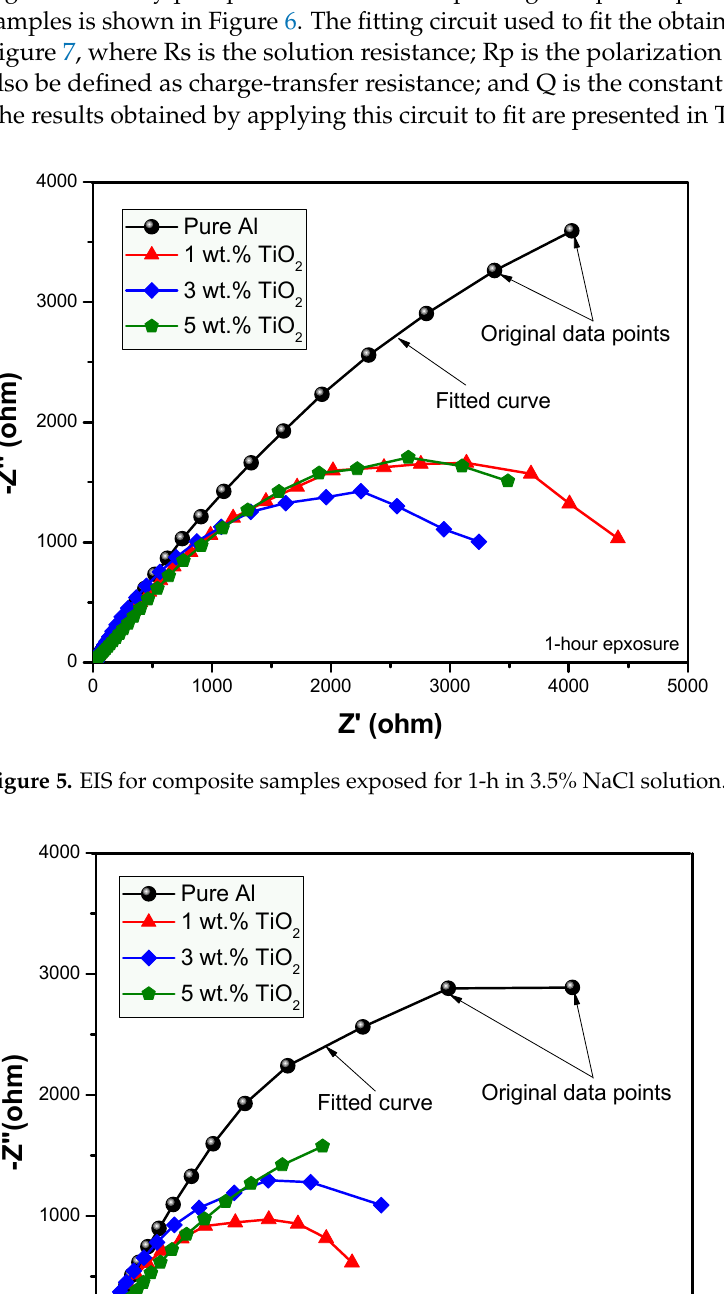
Figure 4. XRD of the 5wt.% Al/TiO 2 consolidated sample.